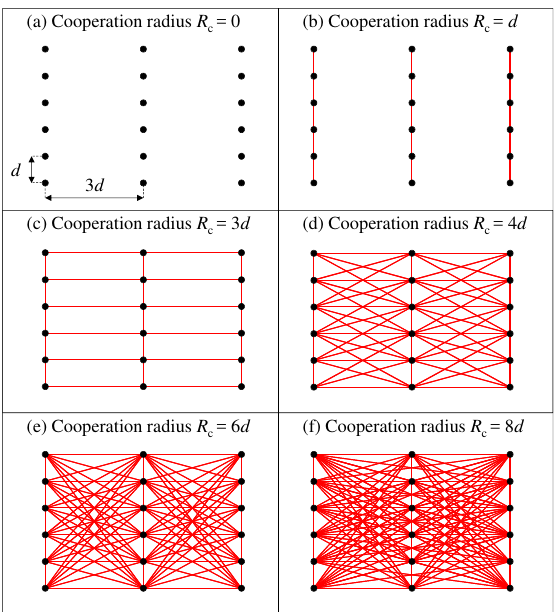
Figure 12. Connectivity graph for cooperation radius R c ∈ { 0, d ,3 d ,4 d ,6 d ,8 d } . Nodes are plotted in black and communication links are shown as red